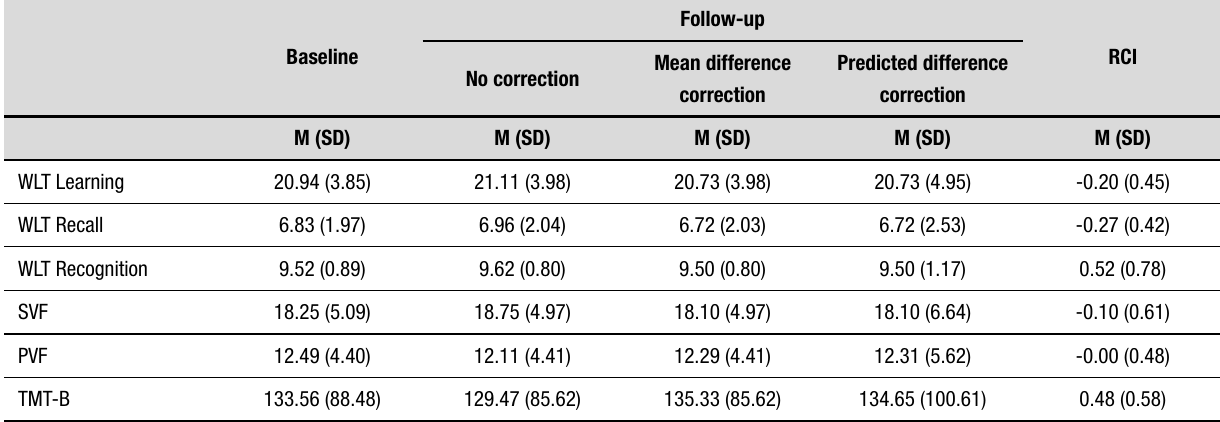
Table 2. Mean and standard deviation for each cognitive test, considering no correction, mean difference correction, predicted difference correction, and Reliable Change Index (n=5,592).